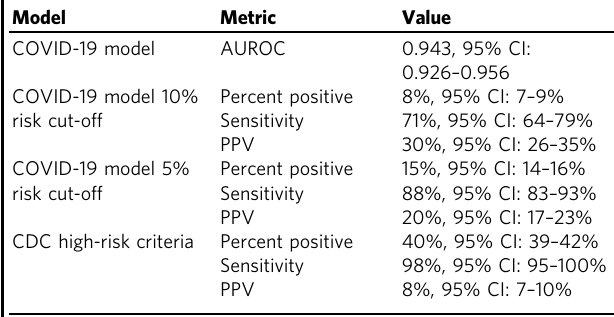
Table 2 COVID-19 predictions performance table.